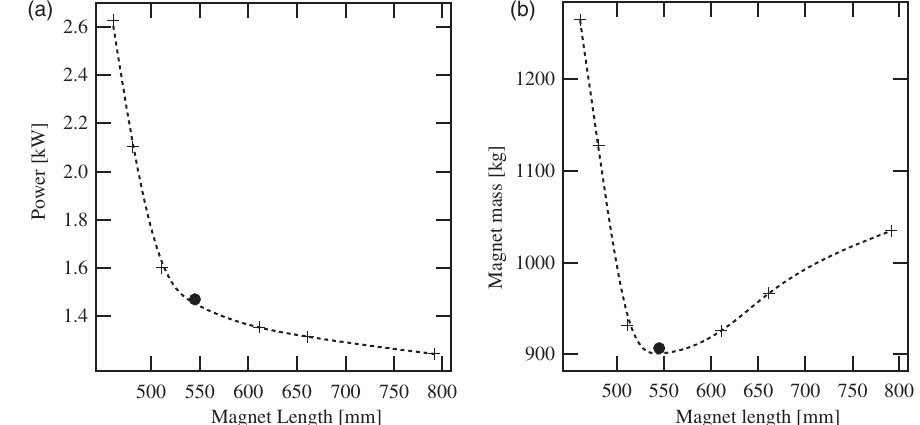
FIG. 4. Magnet power consumption (a) and mass (b) vs total length (including coil heads), at 44 T integrated field gradient and 12.5 mm bore radius. The crosses are 3D simulation results and the black disk indicates the parameters of the prototype magnet. The lines are spline interpolations between the simulated points.